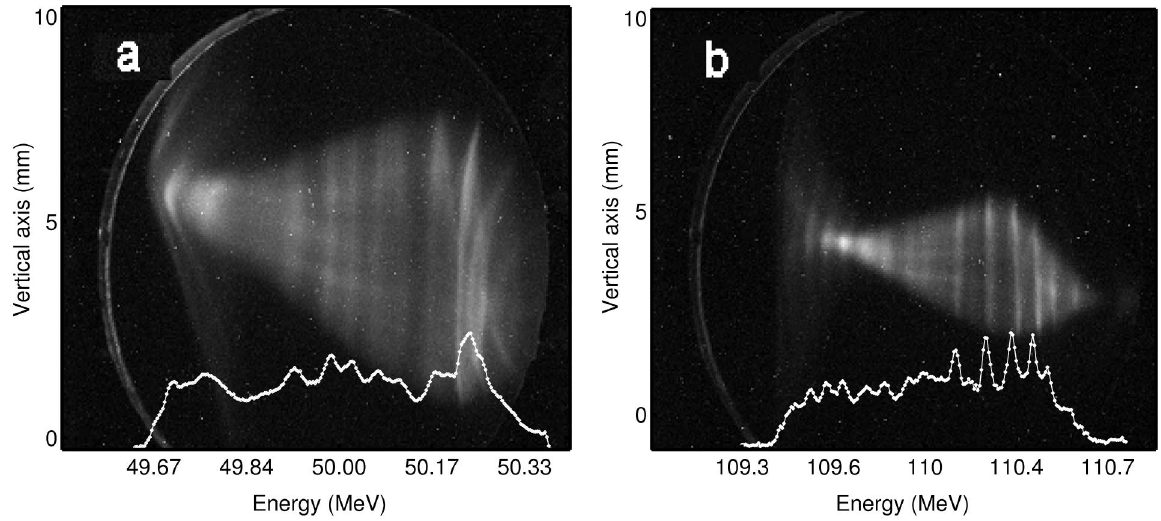
FIG. 2. Monitor after the spectrometer dipole: transverse beam distributions (images) and chirped bunch energy (CBE) spectra (curves) for (a) 50 and (b) 110 MeV. The CBE spectrum is a projection of the image onto the horizontal axis.